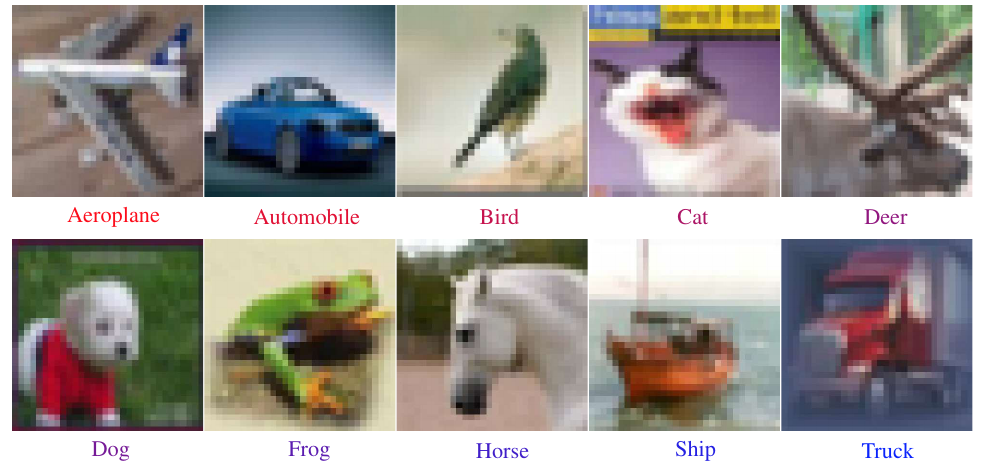
Figure 7. Sample images from the CIFAR-10 dataset. The dataset contains a total of 10 classes, including animals and objects. One image from each class is shown